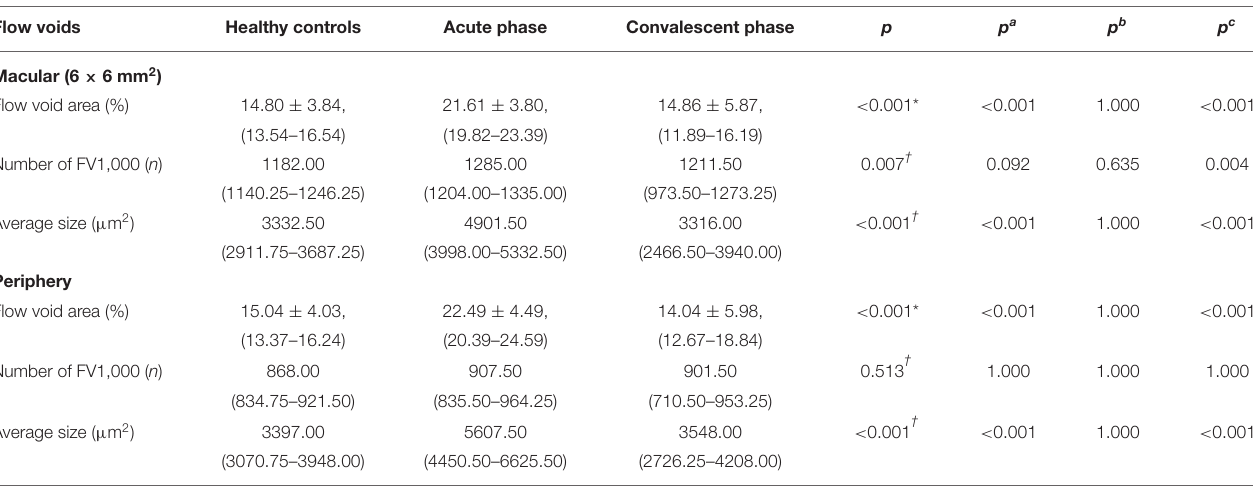
TABLE 4 | The flow void parameters in CC